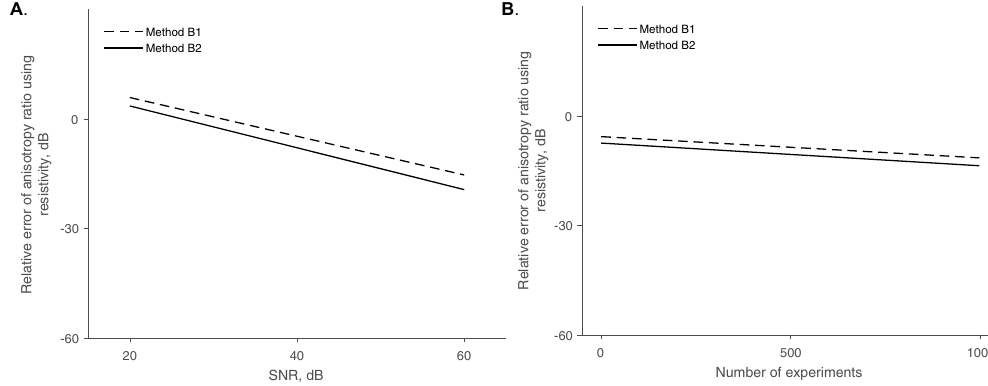
Figure 7. Comparison between methods B1 (dashed black line) and B2 (solid black line) estimating the resistivity anisotropy ratio ˆ α 2 while changing the signal-to-noise ratio (SNR) and keeping the number of measurements constant at M = 10 ( A ); and then while changing the number of measurements performed and keeping constant the SNR = 40 dB ( B ). Rates of decline of the relative error values between the estimated 2 α ˆ and true α 2 resistivity anisotropy ratio value are graphically shown, calculated with a linear regression.